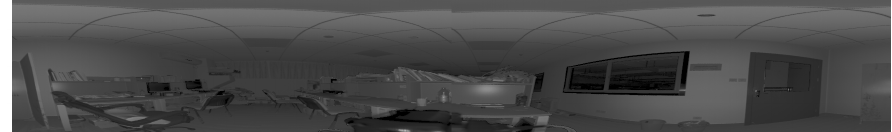
Figure 7. Example of a generated 2D image for one laser